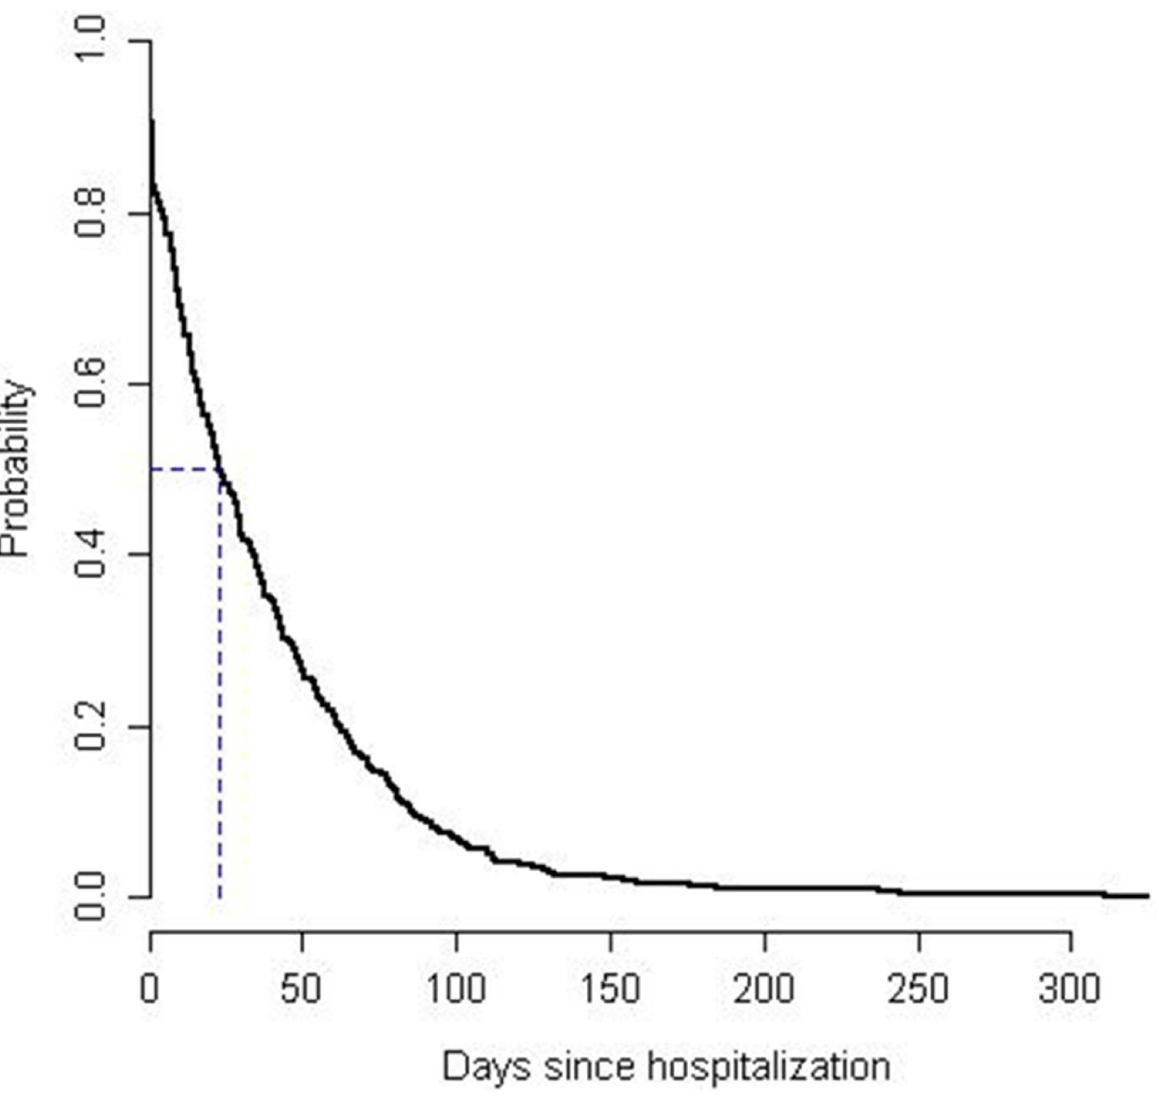
Figure 3. Kaplan-Meier-Curve for hospital length of stay in the BANC study population (n=669).